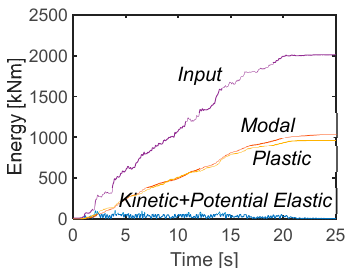
Figure 12. Energy time-histories of the structure.